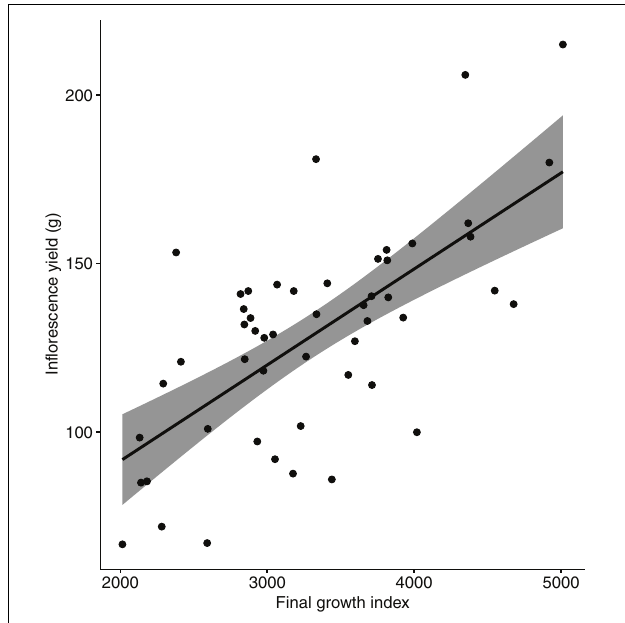
FIGURE 5 | Correlation between inflorescence yield (g/plant) and plant growth index of Cannabis sativa ( r = 0.67, P < 0.001). Shaded area represents 95% confidence interval.